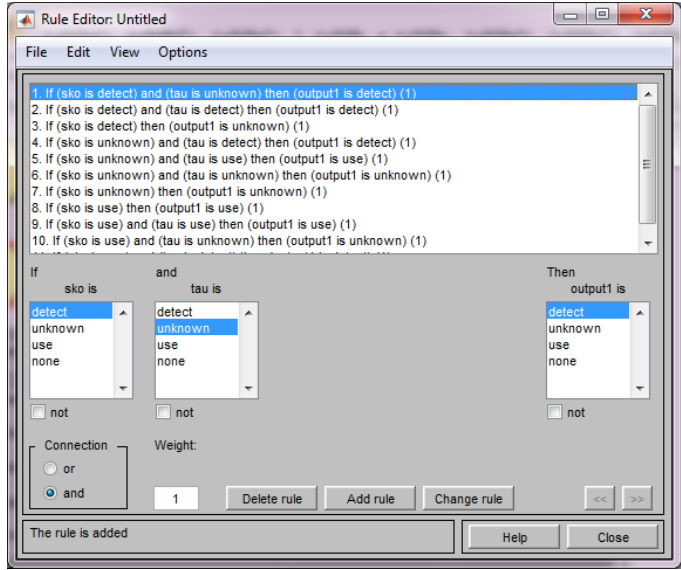
Figure 15. Defining fuzzy logic rules.